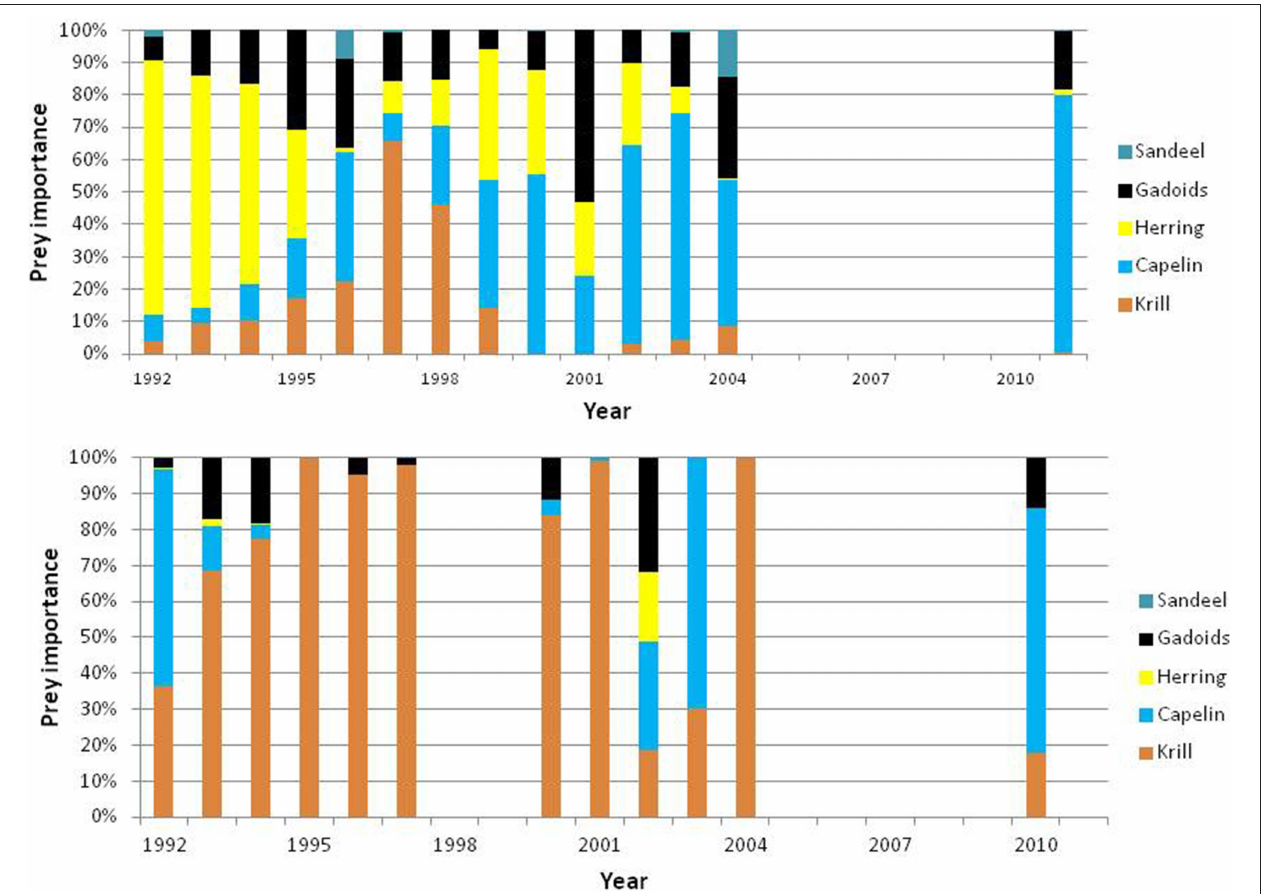
FIGURE 12 | Biomass-based diet composition of minke whales sampled in the northern (North) and southern (South) Barents Sea in the periods 1992–2004 and 2010–2011. Based on data from Haug et al. (2002), Windsland et al. (2007) and Meier et al. (in